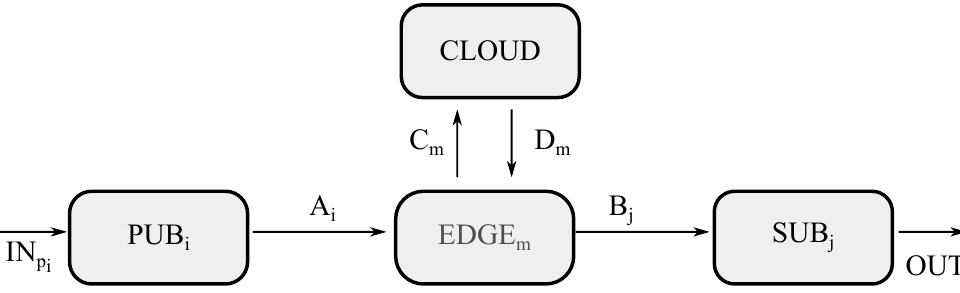
Figure 3. Model for edge computing in